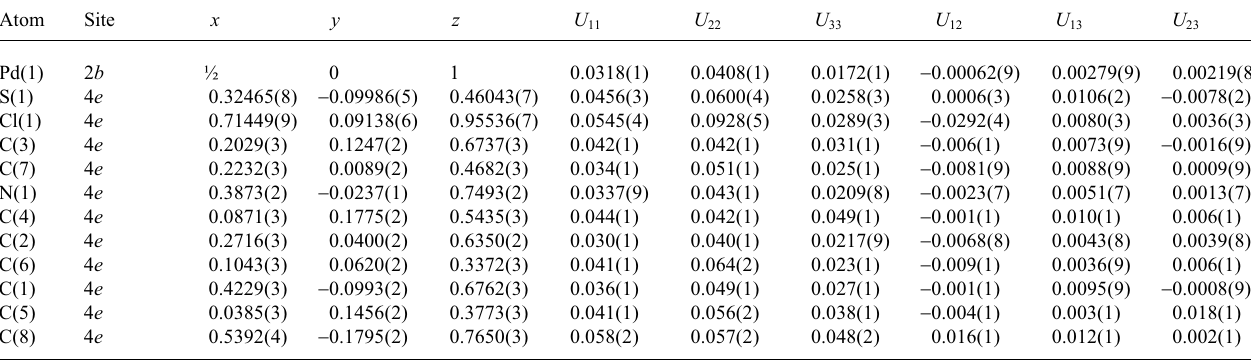
ligands: Crystal structure of the acetone solvate of 2-carboxyquinolinato- carbonyltriphenylphosphinerhodium(I).TransitionMet.Chem. 16 (1991) 193–195. 10.Purcell, W.; Basson, S. S.; Leipoldt, J. G.; Roodt, A.; Preston, H.: First Structural Confirmation of Different Geometrical Isomers in the same Crystal Lattice: The Crystal Structure of Benzoylacetonatocarbonylphos- phinerhodium(I). Inorg.Chim. Acta. 234 (1995) 153–156. 11.Alyea, E. C.; Malek, A.: Synthesis and Characterization of some dibasic tridendate Schiff base ligands. Can. J. Chem. 53 (1975)